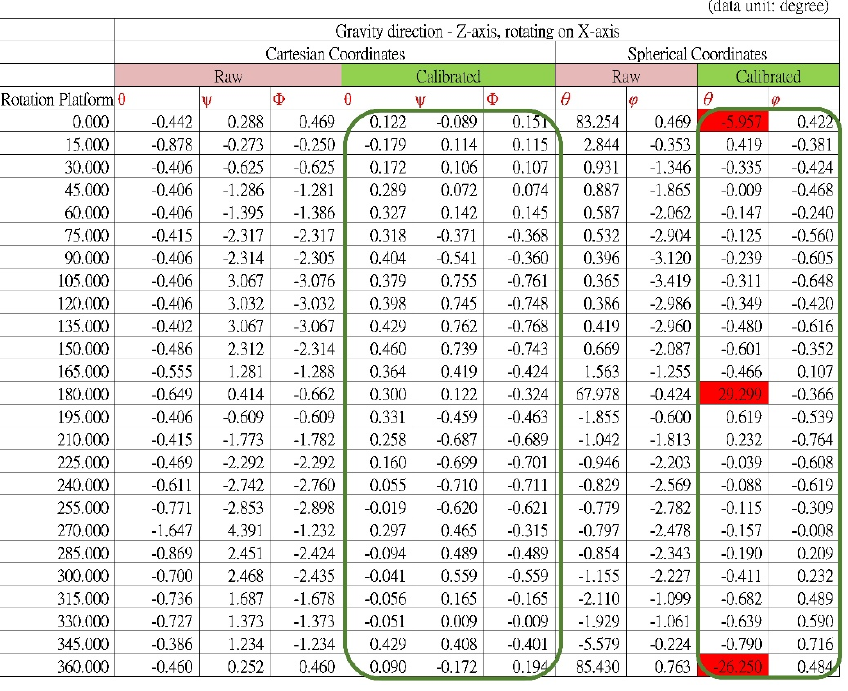
Figure 11. Results of tilt angle